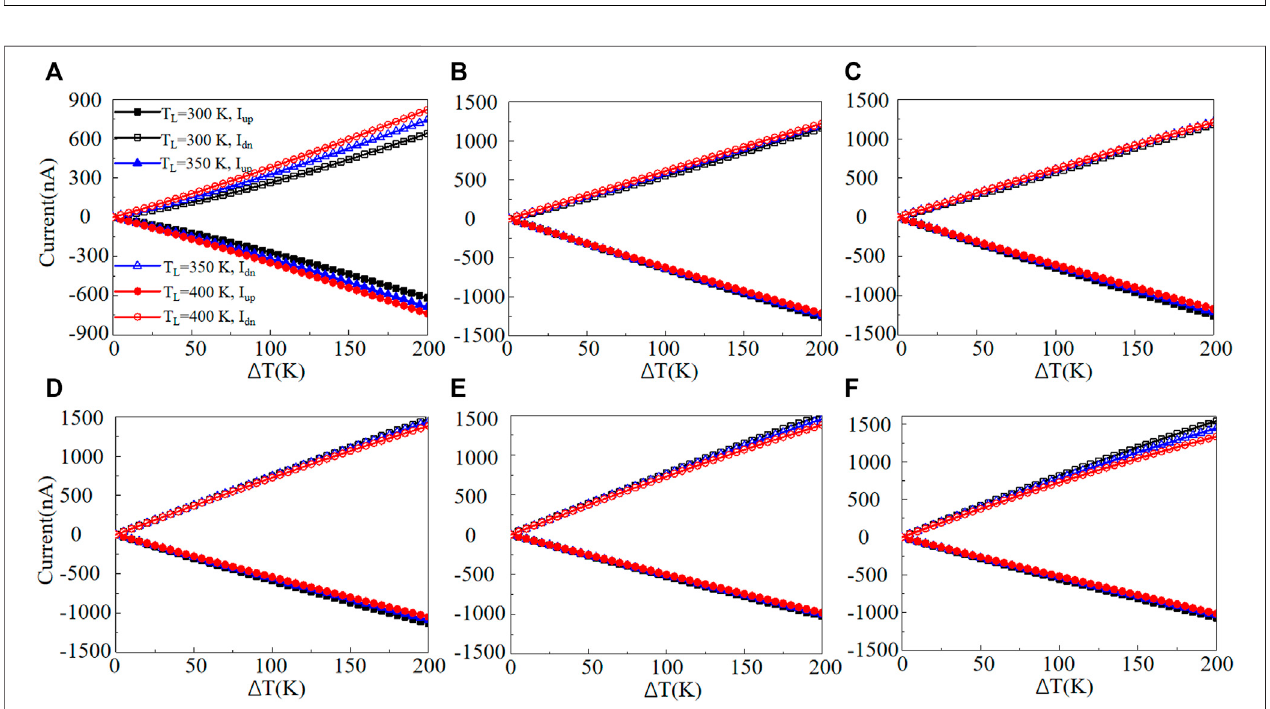
FIGURE 5 | I up and I dn in terms of Δ T for selected values of T L , (A) N = 4, (B) N = 5, (C) N = 6, (D) N = 7, (E) N = 8, (F) N = 9.